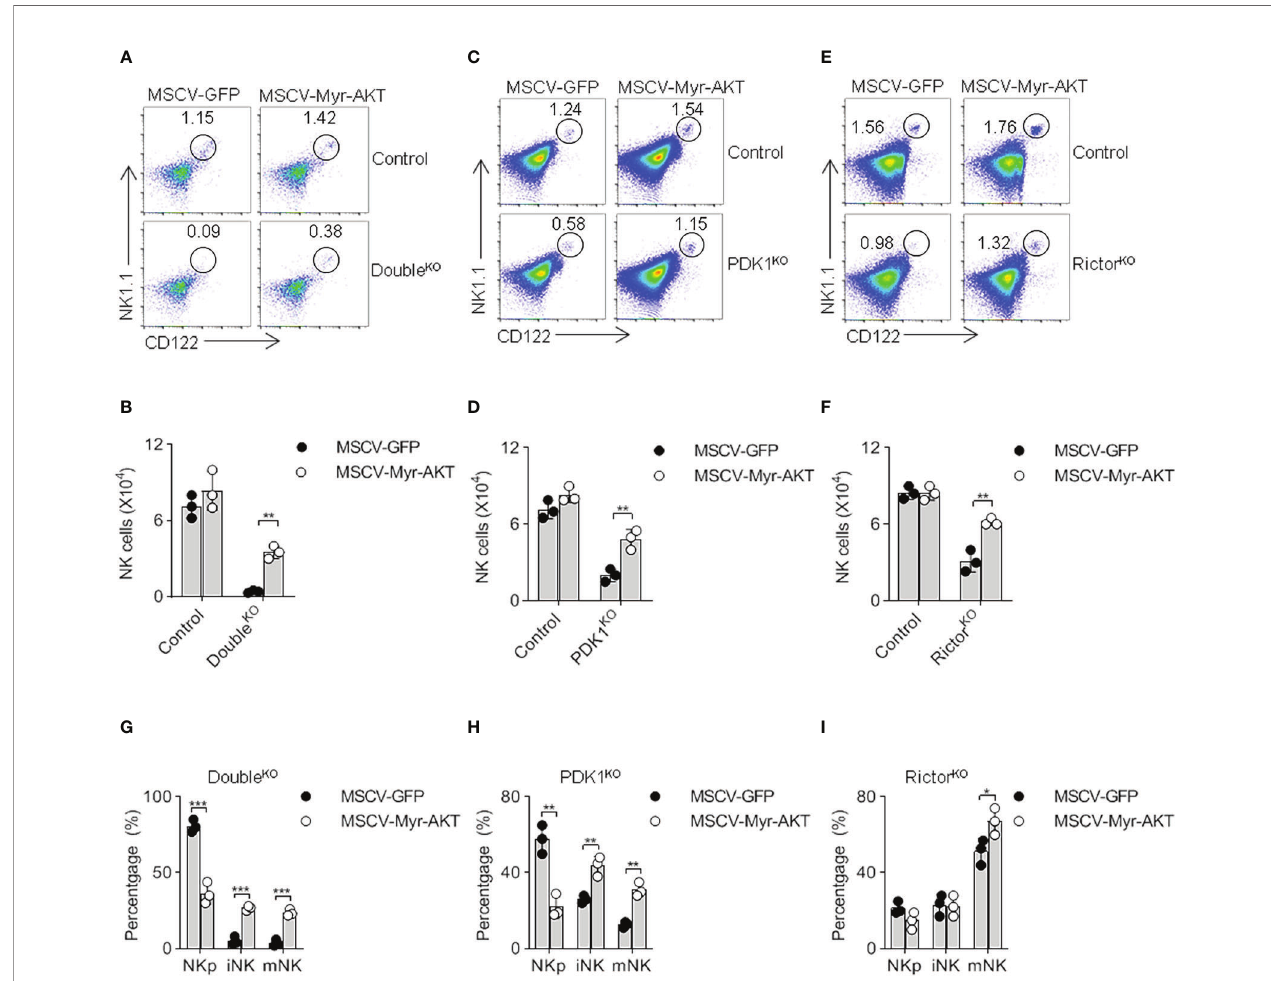
FIGURE 5 | The ectopic expression of myristoylated PKB corrects the defect of NK cell development. (A – F) Double- (A, B) , PDK1- (C, D) or Rictor-de fi cient (E, F) mice were treated with 5-FU for 4 days, and bone marrow cells were collected for spin-infection with MSCV retrovirus encoding control GFP, or Myr- AKT (activated-PKB). The infected BM cells were then transferred into recipient mice. After 8 weeks, CD122 vs NK1.1 expression on gated CD3 − cells was analyzed by fl ow cytometry. The numbers in the outlined areas indicate the percent of CD3 − CD122 + NK1.1 + cells (A, C, E) . Numbers of CD3 − CD122 + NK1.1 + cell are enumerated (B, D, F) . (G – I) The developmental stages of NK cell was analysed after replenish Myr-AKT to HSC of Double-, PDK1- or Rictor-de fi cient mice (G – I) . The data represent one of three independent experiments, n ≥ 3 for each experiment, and values are expressed as the mean ± SD. *p < 0.05, **p < 0.01, ***p <